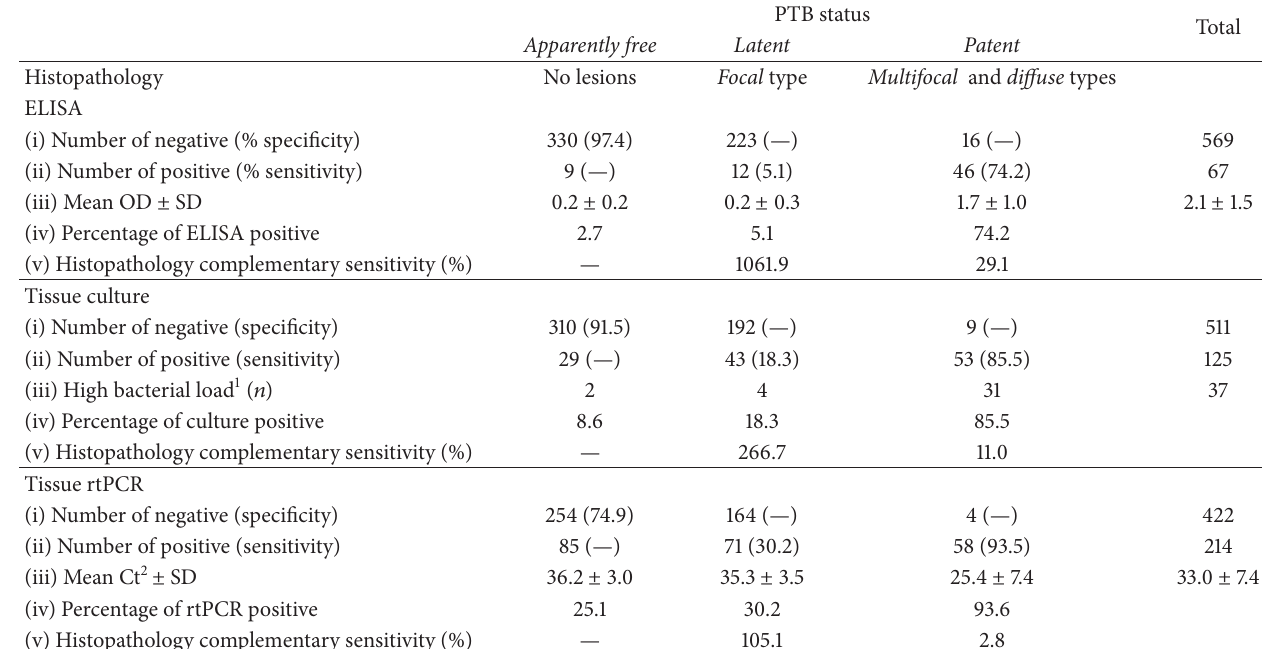
Table 1: Characterization of paratuberculosis (PTB) status of the subgroup of 636 animals considered in genotypic association analysis, according to histopathological findings, seroprevalence estimates, and frequency of MAP detection in